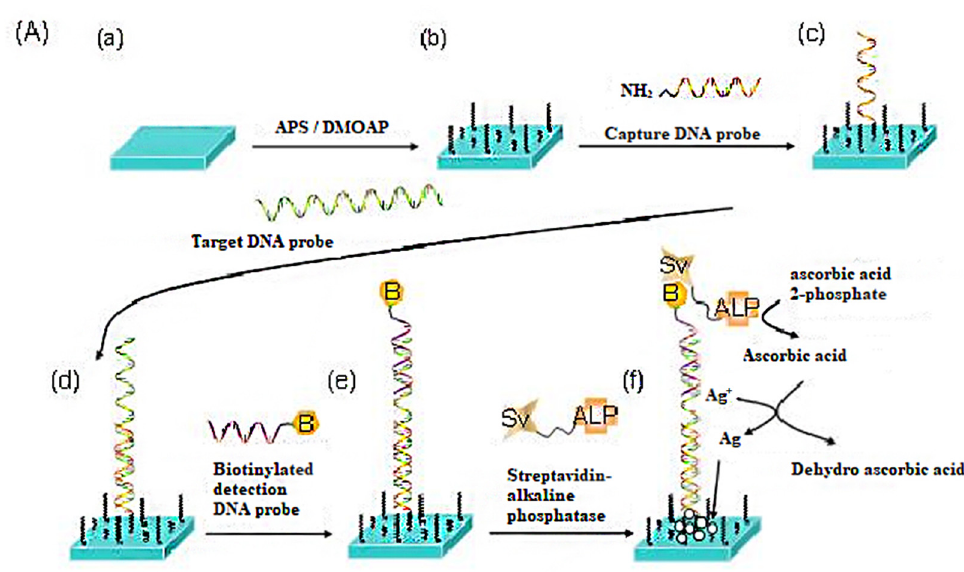
Figure 8. Stepwise assembly of the signal-enhanced LC DNA biosensing substrate based on enzymatic silver deposition: ( a ) cleaned glass slide; ( b ) self-assembled APS / DMOAP film; ( c ) immobilization of cap-ture DNA Probe; ( d ) hybridization with target DNA; ( e ) hybridization with biotinylated detection DNA probe; ( f ) association with streptavidin alkaline phosphatase and reduction of silver ions by ascorbic acid [29].